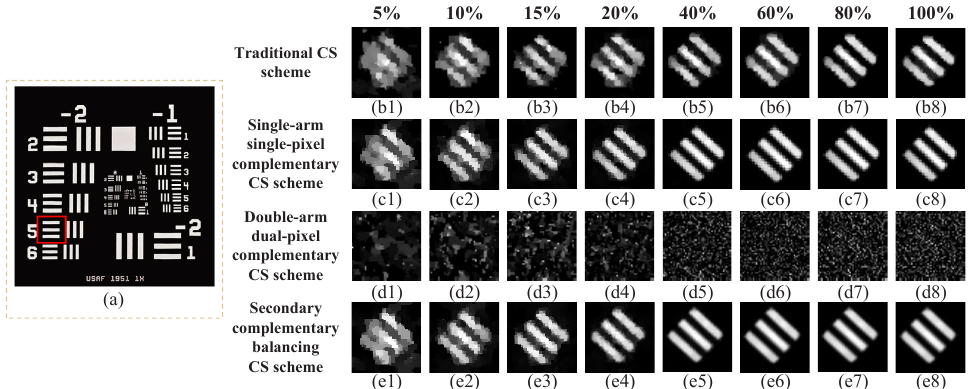
Figure 6. Experimental results of four CS schemes using different sampling rates (5%, 10%, 15%, 20%, 40%, 60%, 80% and 100% from left to right) in the imbalanced case. ( a ) The stripe pattern marked in the red square of the negative 1951 USAF resolution test chart is treated as the original